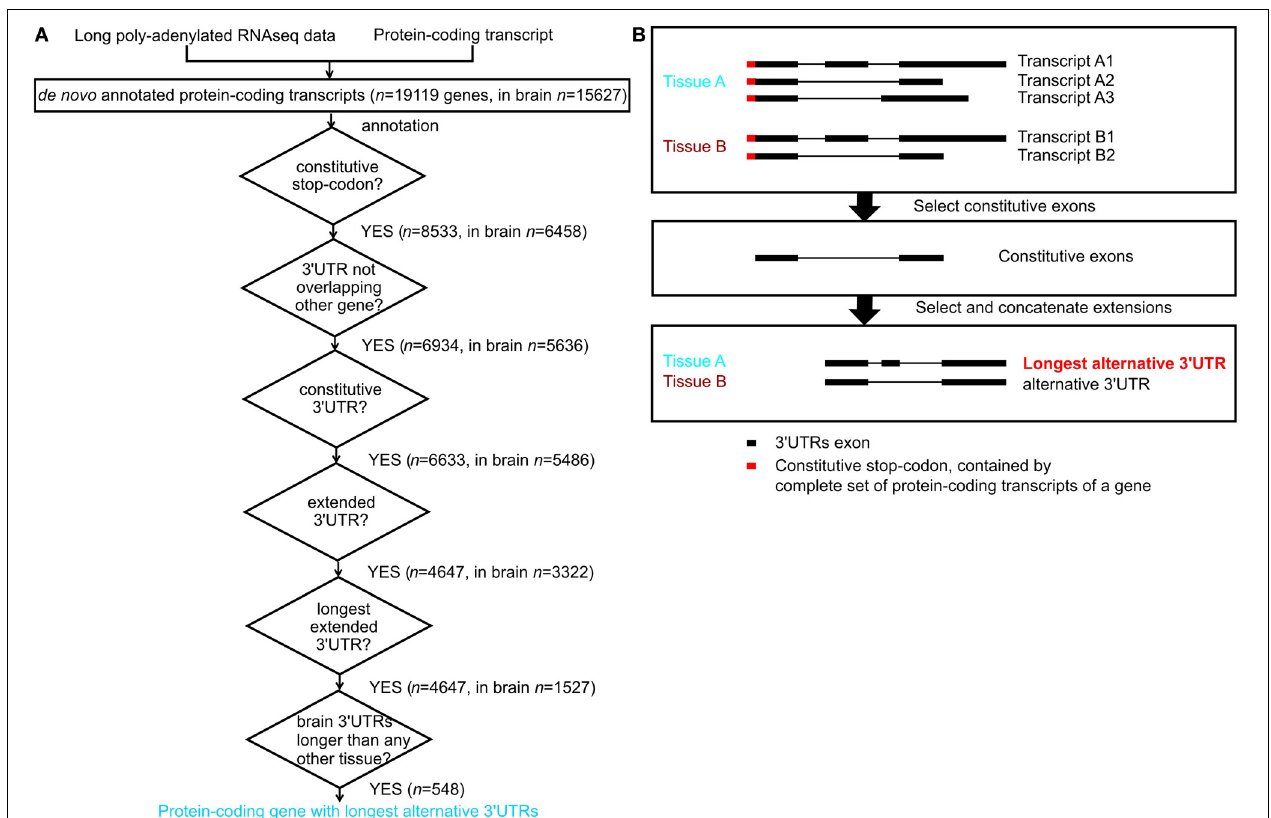
the nucleotides expressed in all transcript of a gene across all tissues where the gene is expressed (middle panel). The extended alternative 3 (cid:2) UTRs is the consensus transcript for a gene in a given tissue after constitutive parts have been removed. Tissue A expresses the longest alternative 3 (cid:2) UTRs for this gene, as it contains more nucleotides than the alternative 3 (cid:2) UTRs in tissue B (bottom